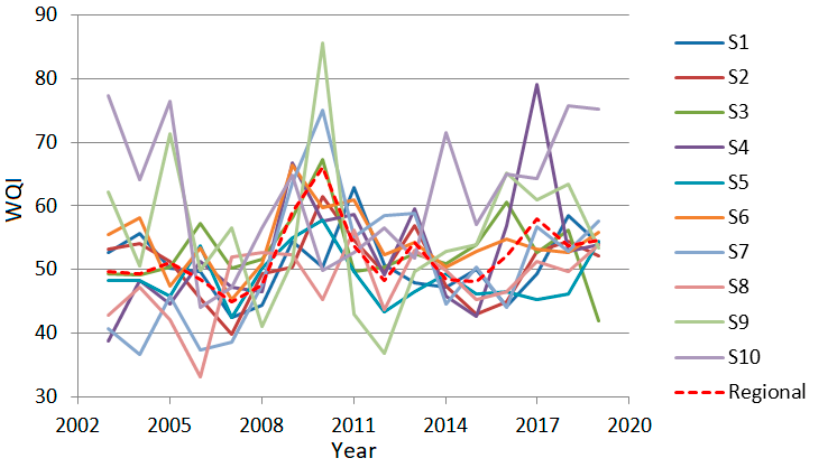
Figure 8. The regional WQI series.